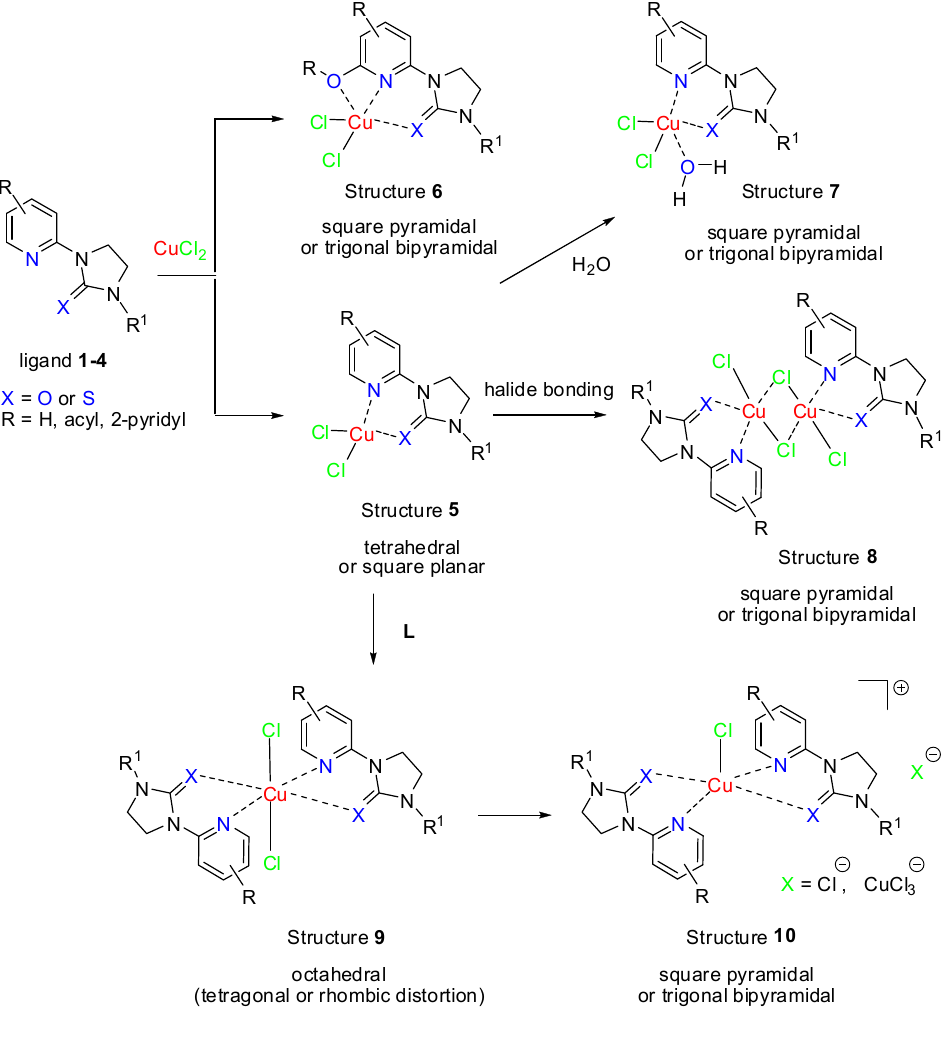
Scheme 3. Reaction of N -(2-pyridyl)imidazolidin-2-one(thione) ligands 1 , 2 , 3 and 4 with CuCl 2 .